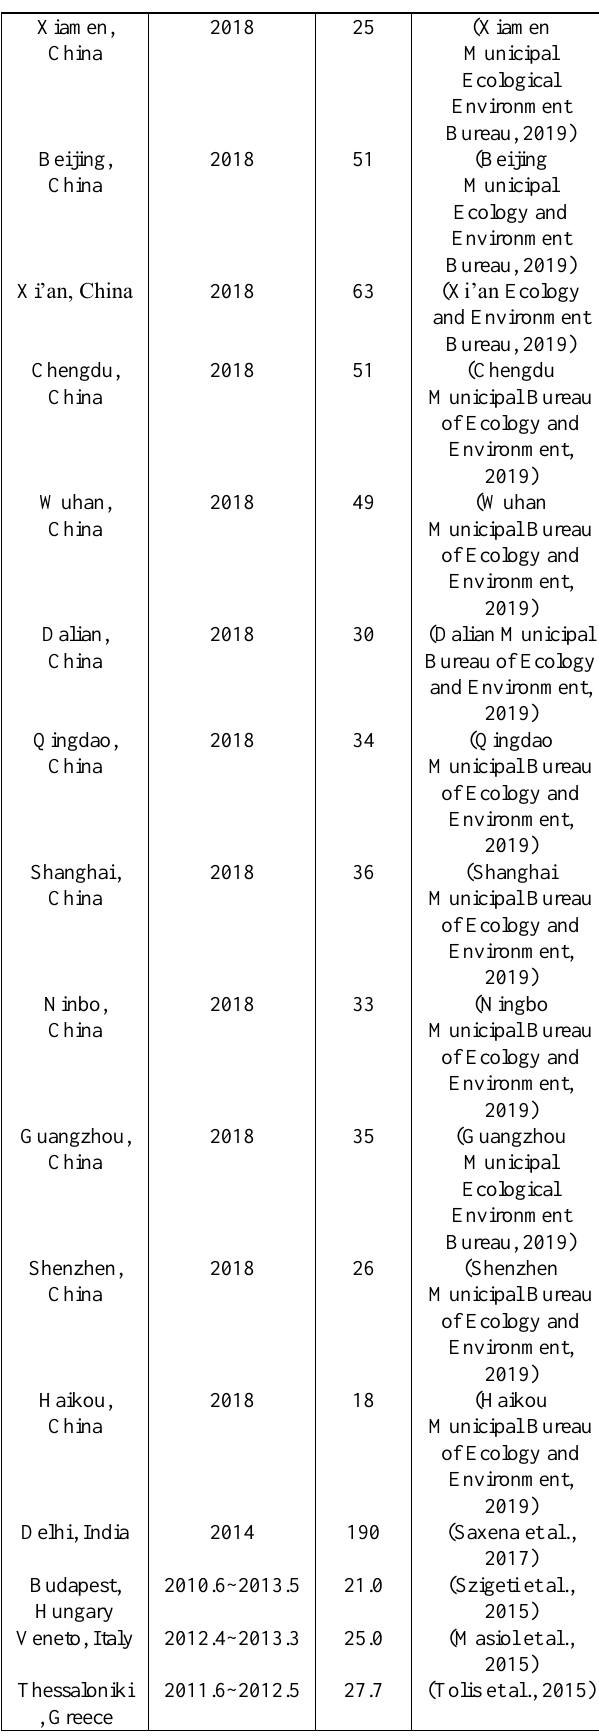
Table 1. Comparisons of PM 2.5 concentrations in other cities